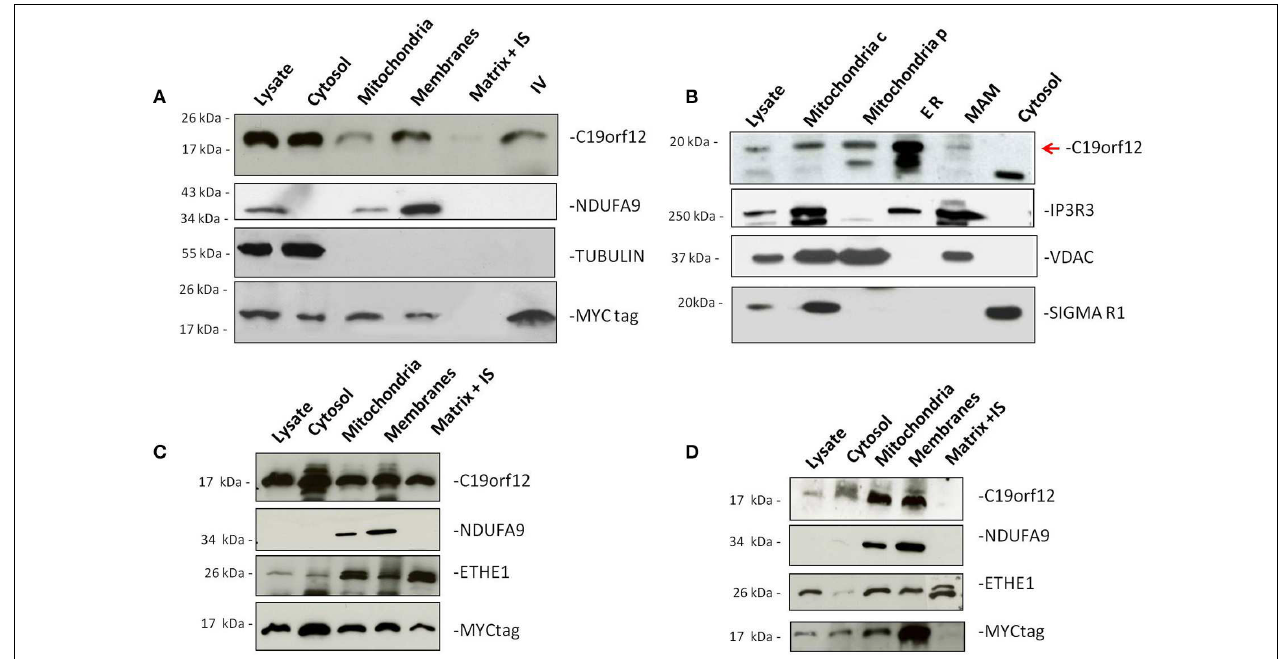
FIGURE 1 | Subcellular localization of wild-type and mutant C19orf12. HeLa cells transfected with wild-type C19orf12 MYC construct (A) and mutant versions G58S − C19orf12 MYC construct (C), and Q96P − C19orf12 MYC construct (D) , were harvested to obtain mitochondria and other fractions. Equal amount of proteins (30 µ g) from each fraction were resolved by SDS-PAGE and immunostained with antibodies against C19orf12 and MYC to specifically detect protein sub-localization. Anti-NDUFA9, TUBULIN, and ETHE1 were used as